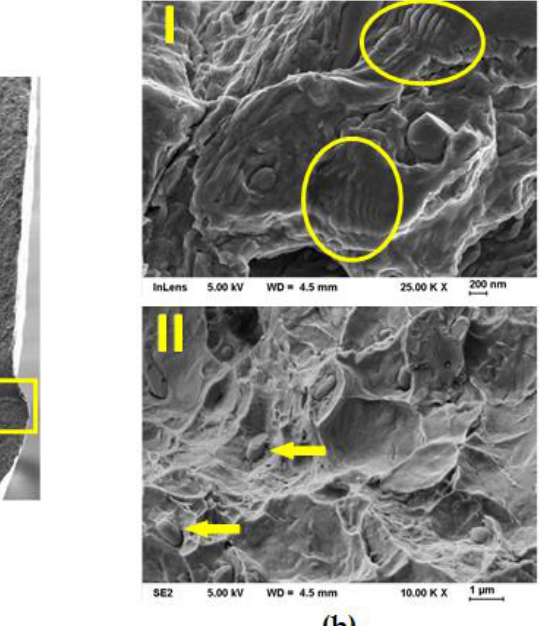
Figure 11. ( a ) Fatigue fracture surface of a QP1 specimen with ( b ) different fracture areas.